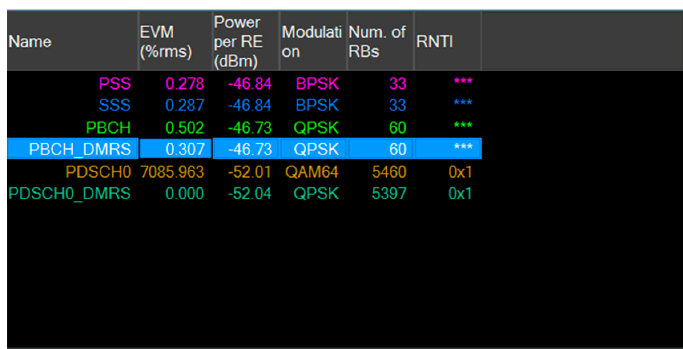
Figure 8. Screenshot of the 5G demodulation software with many relevant characteristics of the detected signal #1, such as the In-phase and Quadrature (IQ)diagram, the carrier vs. time allocation map, and the detected power level for control channels, data channels, and SS-Blocks.